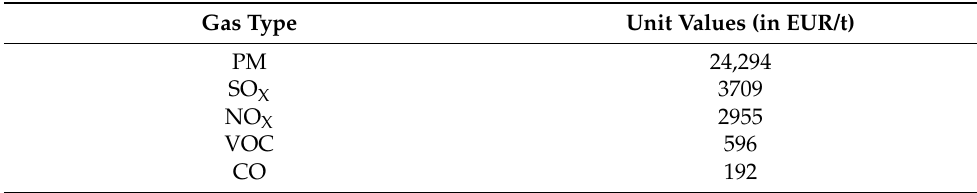
Table 12. Unit values of pollution costs by types of gases adjusted for